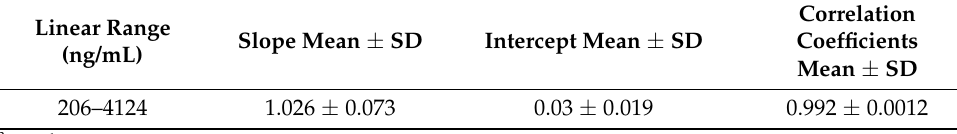
Table 5. Analytical parameters of the developed HPLC-PDA method for capmatinib.